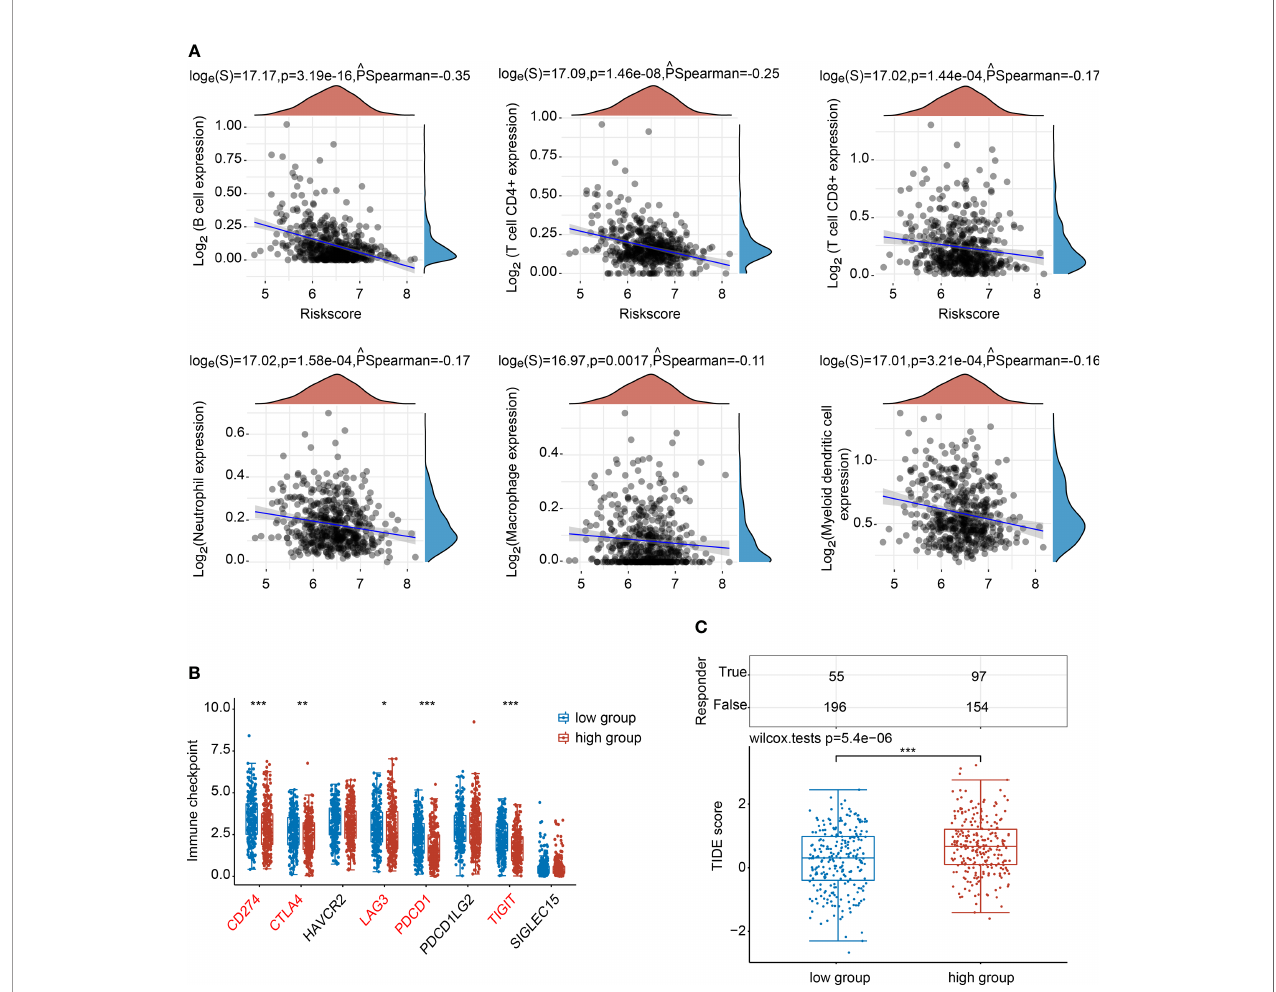
FIGURE 6 | Correlations between NTF2 and immune status in HNSCC patients. (A) Spearman analysis between NTF2 and immune score. (B) Correlation analysis between NTF2 and immune checkpoint-related gene expression using Wilcox on test. (C) Potential immunotherapeutic responses were predicted through the